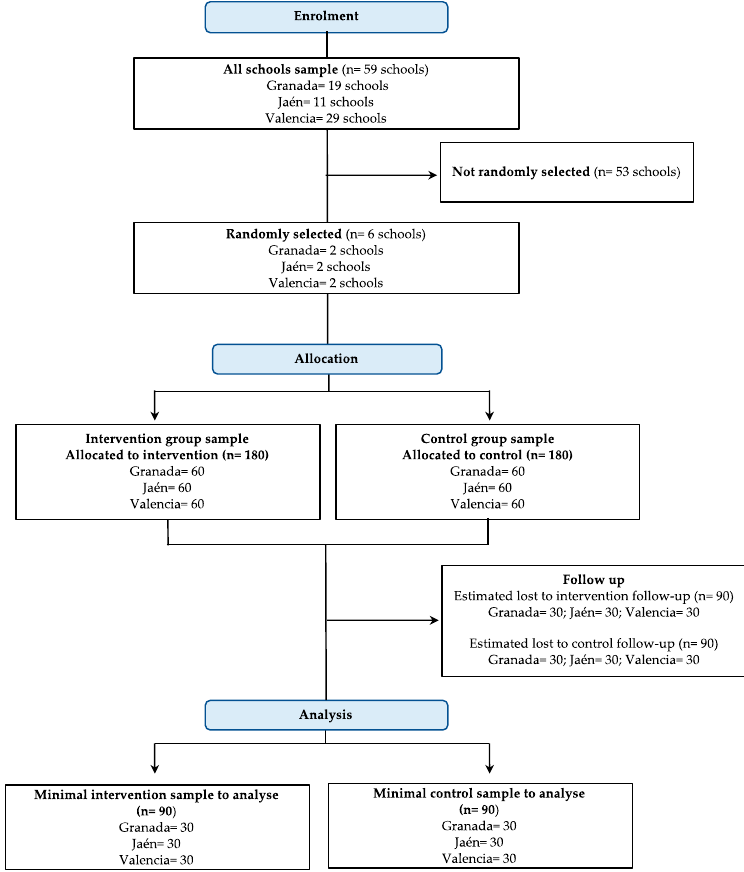
Figure 3. Plan flow chart of the PACO study.